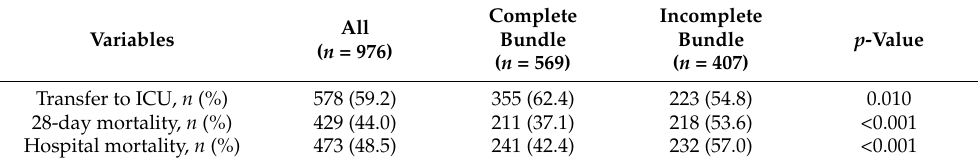
Table 3. Clinical outcomes ( n = 976).